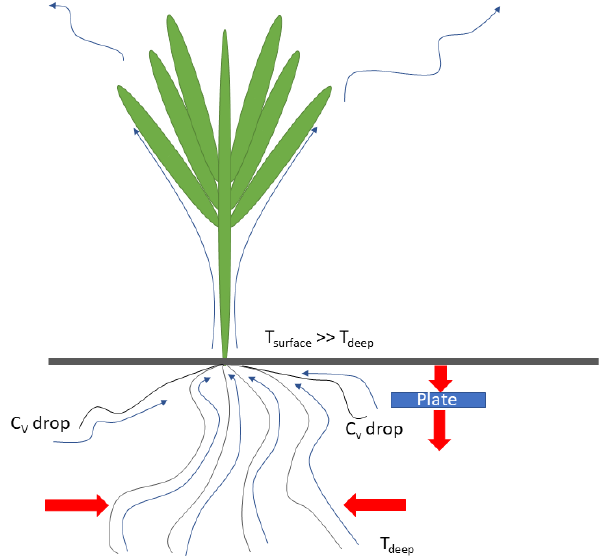
Figure 5. Root-absorbed water flows up from the deep soil at low temperature to the hot sun-heated soil surface, provoking a heat transfer between the soil and the roots. Shallow roots absorb wa- ter, drying soil and lowering its volumetric heat capacity C V . Water is stored, and then energy is evacuated from the